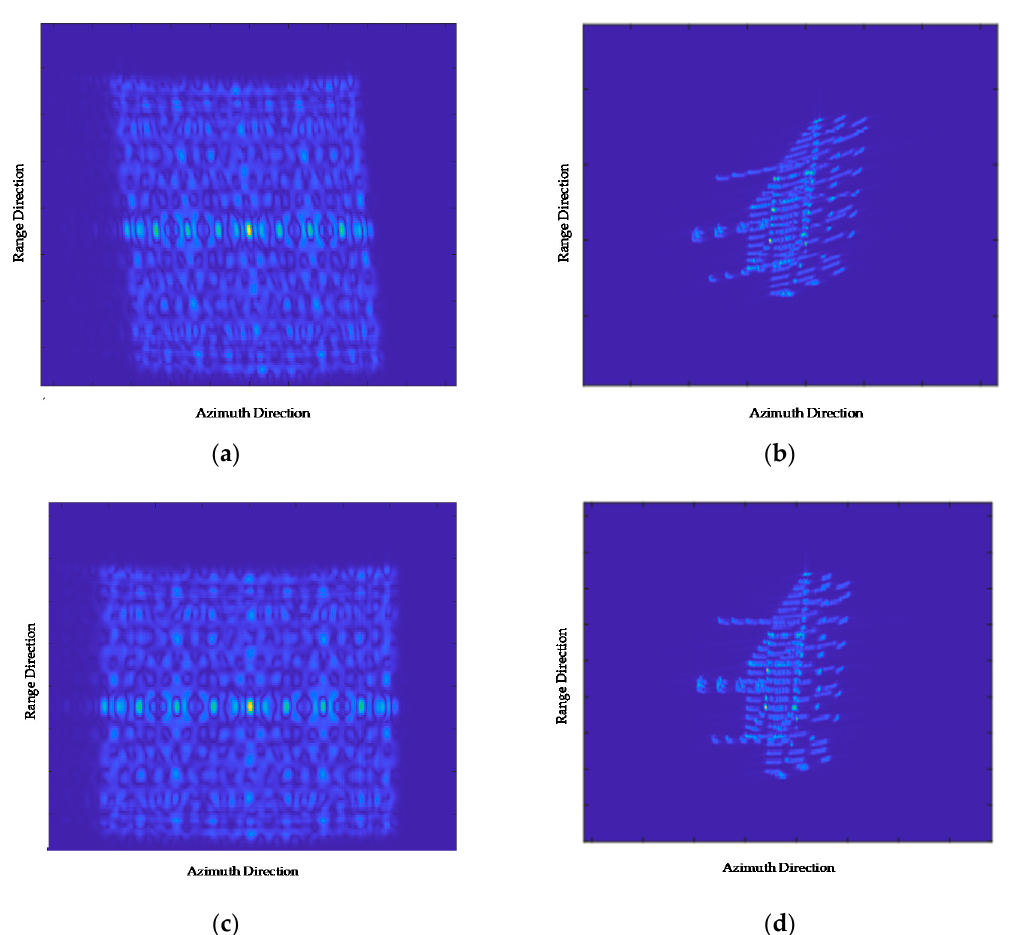
Figure 11. Results of the simulation experiment: ( a ) 2-D wavenumber spectrum of the rough image; ( b ) Rough result of the ship target obtained via the BP algorithm; ( c ) 2-D wavenumber spectrum of the image after the squint minimization process; ( d ) The image after squint minimization.